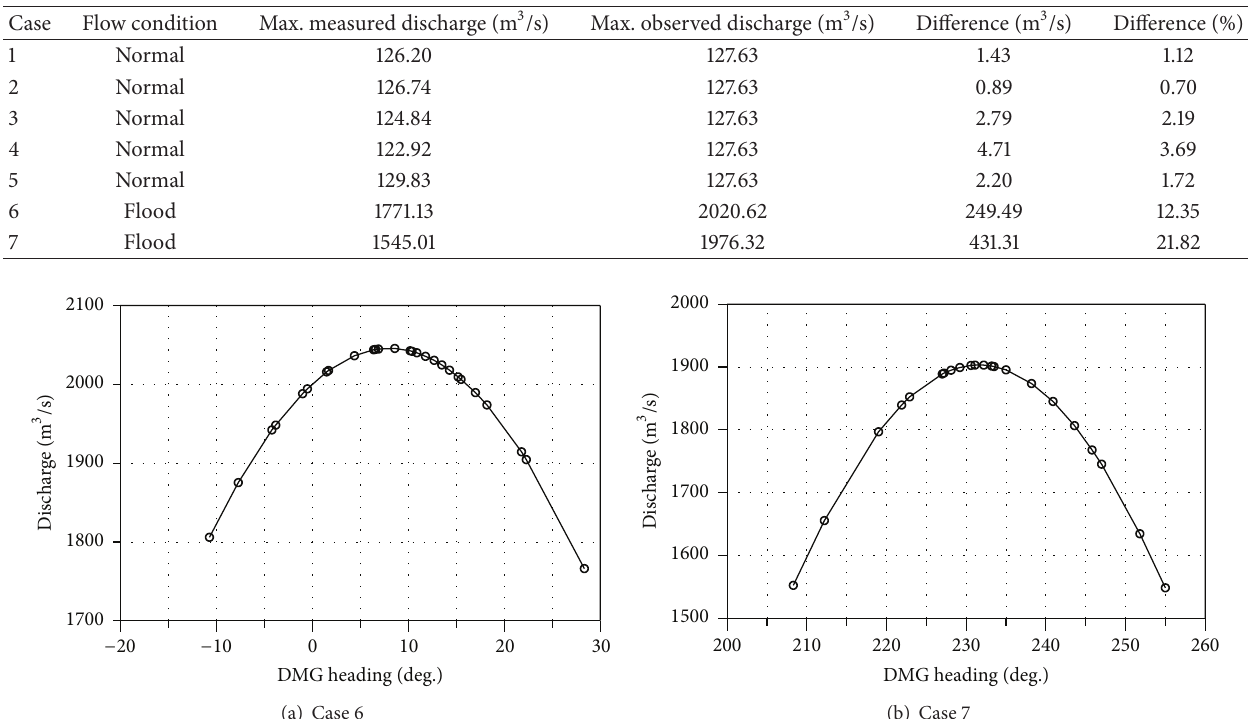
Table 5: Comparison of maximum measured and observed discharge.